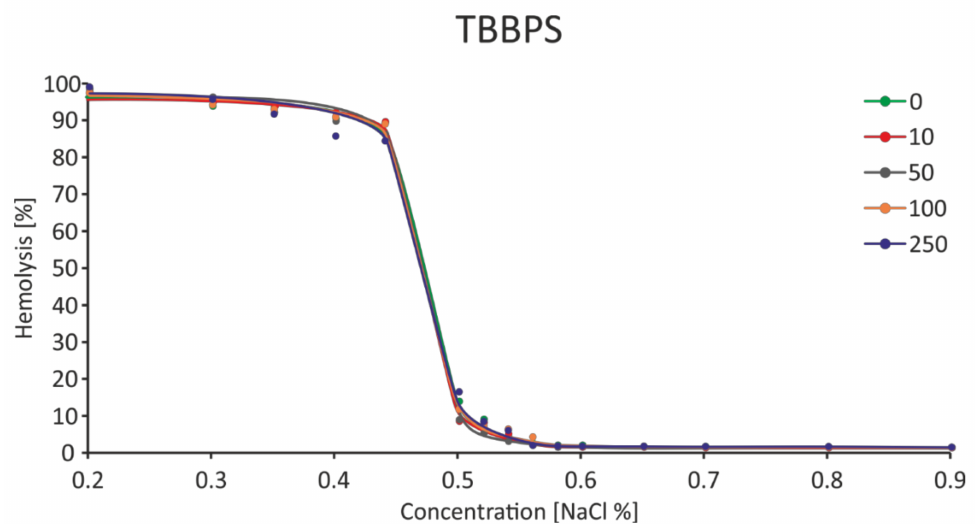
Figure 11. Changes in osmotic resistance of human erythrocytes incubated with TBBPS at 1 to 250 µ g/mL for 3 h.